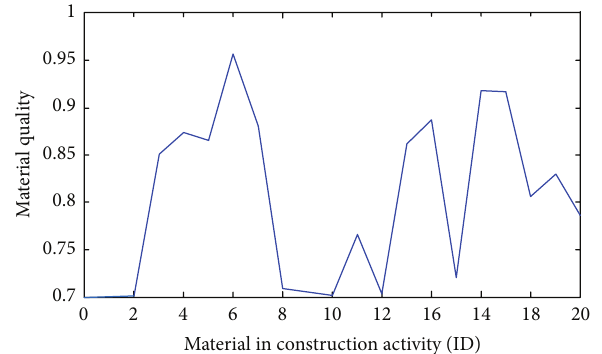
Figure 5: Optimized material quality performances in twenty activ-